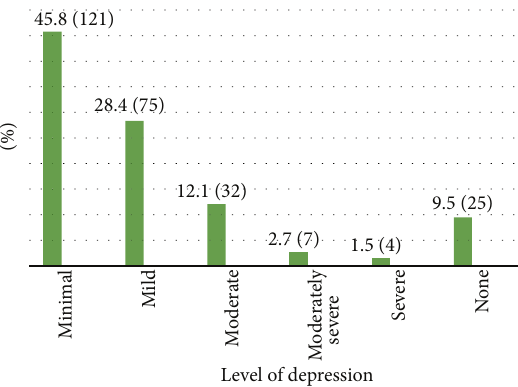
Figure 3: The prevalence of comorbid depression based on PHQ 9 score among type 2 diabetic outpatients in Black Lion General Specialized Hospital, Addis Ababa, Ethiopia, 2013.